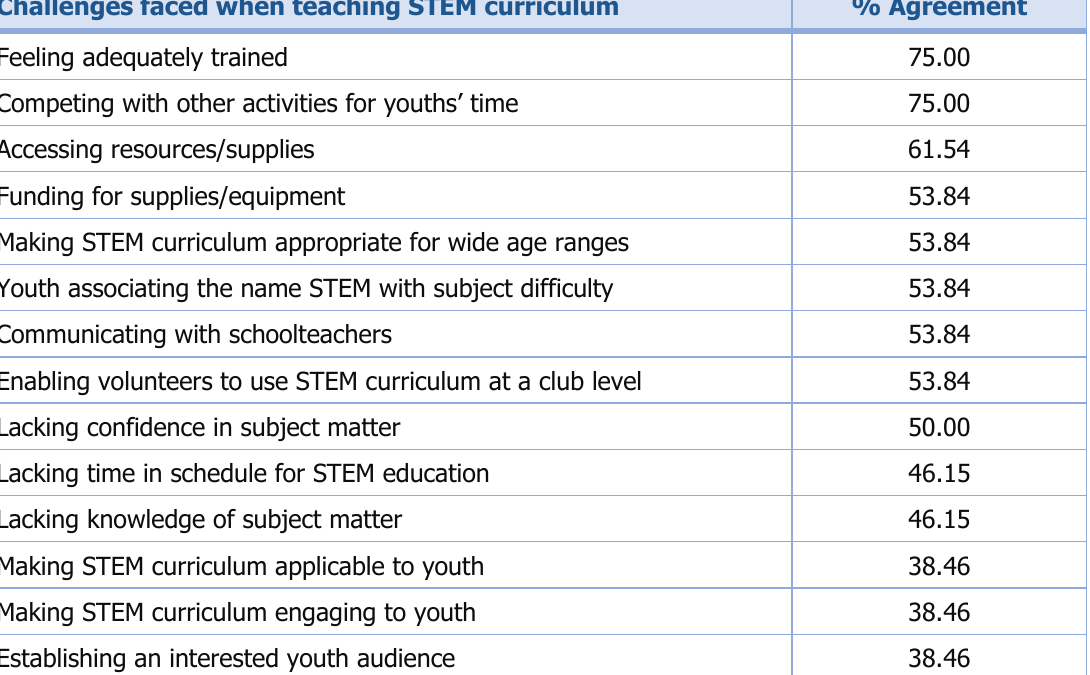
Table 2. Challenges Statements and Agreement Percentages in Round 2: Educator Panel (N = 13)